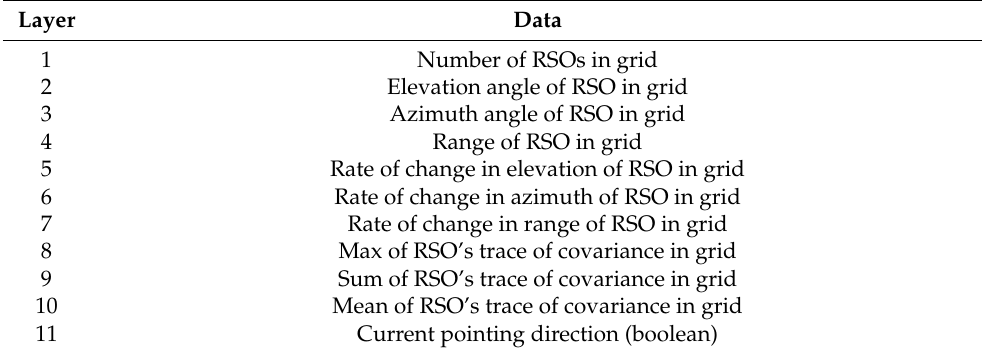
Table 3. Observation information for each grid in the observation.